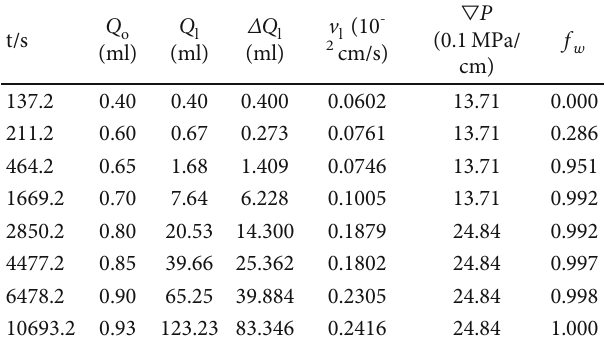
Table 4: Experimental data of oil – water relative permeability of core C116.